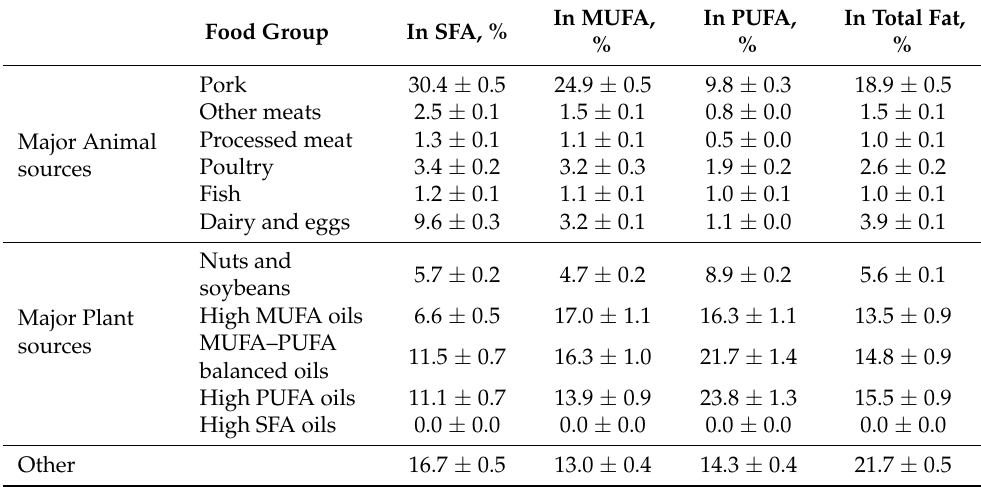
Table 2. Age-sex-standardized proportion of various fat sources in various types of fats and total fat ( n = 48,315)